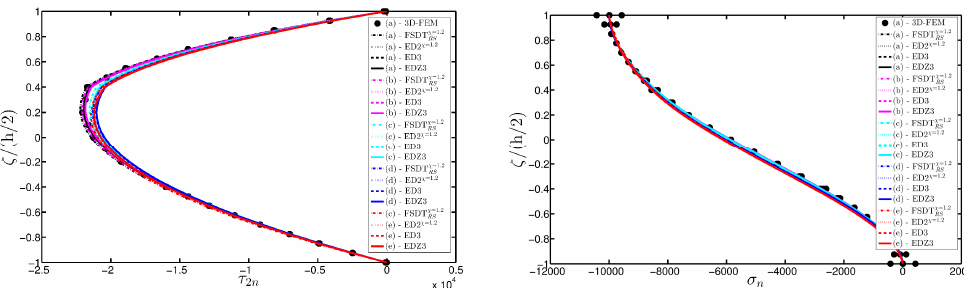
Figure 15. Through-the-thickness profiles of stress components [Pa] for the CCCC laminated square plate with ( − 45/0/45 ) as stacking sequence computed at the point A for different HSDTs. The effect of the damage is investigated by varying the parameters of the function Gau-4.